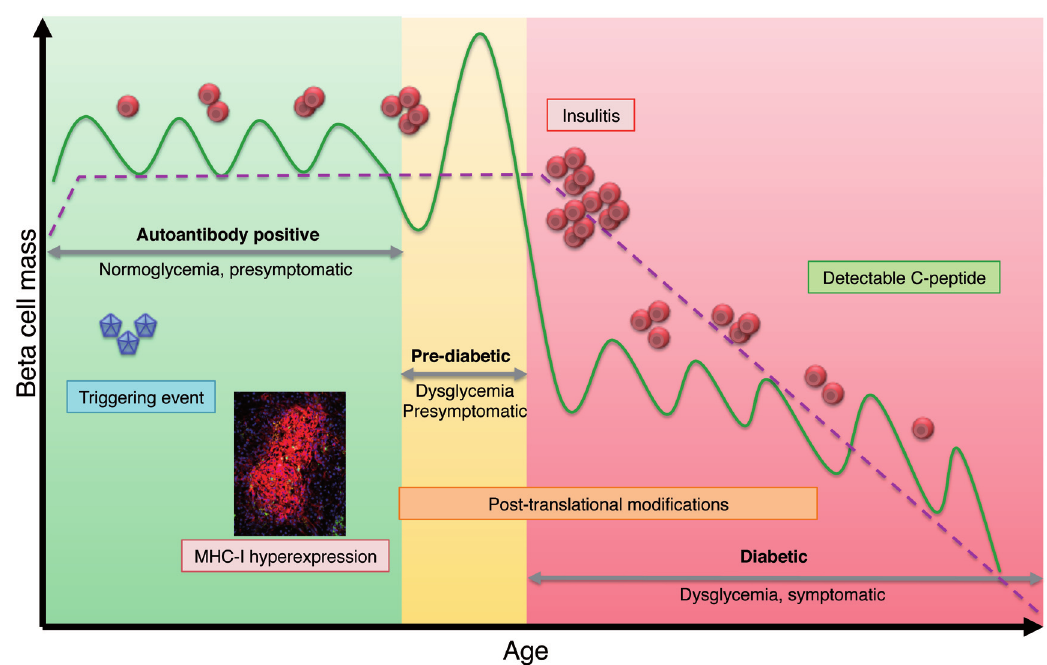
Figure 1. What does the type 1 diabetes scenario look like nowadays? Genetically predisposed individuals are exposed to a triggering event, which induces inflammation and upregulation of major histocompatibility complex class I (MHC-I) molecules in endocrine cells. Autoantibodies against islet antigens appear in the circulation during the autoantibody-positive phase. In this period, blood glucose levels are normal and there are no evident symptoms of the disease. During this chimera of normality, autoreactive T cells proliferate and start to infiltrate the islets, causing waves of beta cell death. In this period, an imbalance between beta cell death and survival generates small fluctuations in beta cell mass. The immune infiltration becomes apparent during the pre-diabetic phase, in which infiltrating cells actively destroy beta cells at a faster pace, a phenomenon that cannot be overcome by endogenous regulatory elements. Dysregulation of glucose levels starts to appear because of the inability of the remaining beta cells to produce enough insulin. In addition, post-translational modifications (PTMs) might arise as a consequence of endoplasmic reticulum stress and inflammation, potentiating the activation of cytotoxic CD8 + T cells and further beta cell destruction. PTMs might expand into the diabetic period, as inflammation is still present. At diagnosis, the number of cells infiltrating the islets is large and insulitis becomes more apparent. The decline in beta cell mass makes it impossible to control glucose levels, and the first symptoms of disease start to appear. During the first years of the diabetic period, C-peptide might still be detectable as some beta cells manage to survive the immune attack. However, as beta cell mass diminishes, so do inflammation and infiltration. Overall, fluctuations in beta cell mass over the years create a continuous relapsing-remitting phenotype with a more abrupt fall around the time of diagnosis, when a critical beta cell mass is